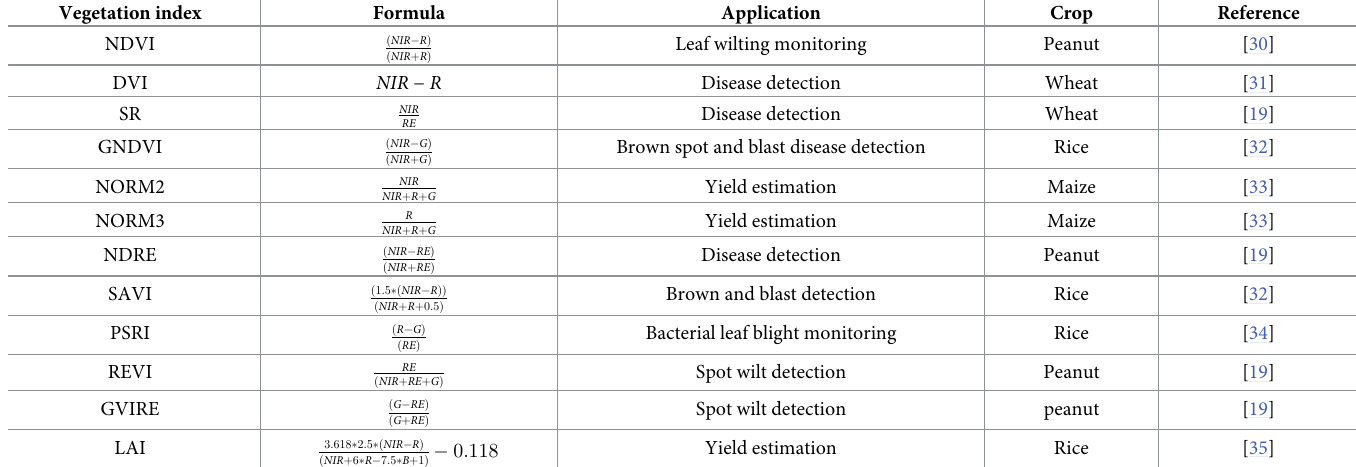
Table 1. The list of vegetation indices used for LLS monitoring in this study. Note that R , G , B , NIR and RE represent the spectral bands: Red (630-690nm), Blue (460- 510nm), Green (545-575), Near-Infrared (820-860nm), and Red-edge (712-722nm) respectively. Vegetation index